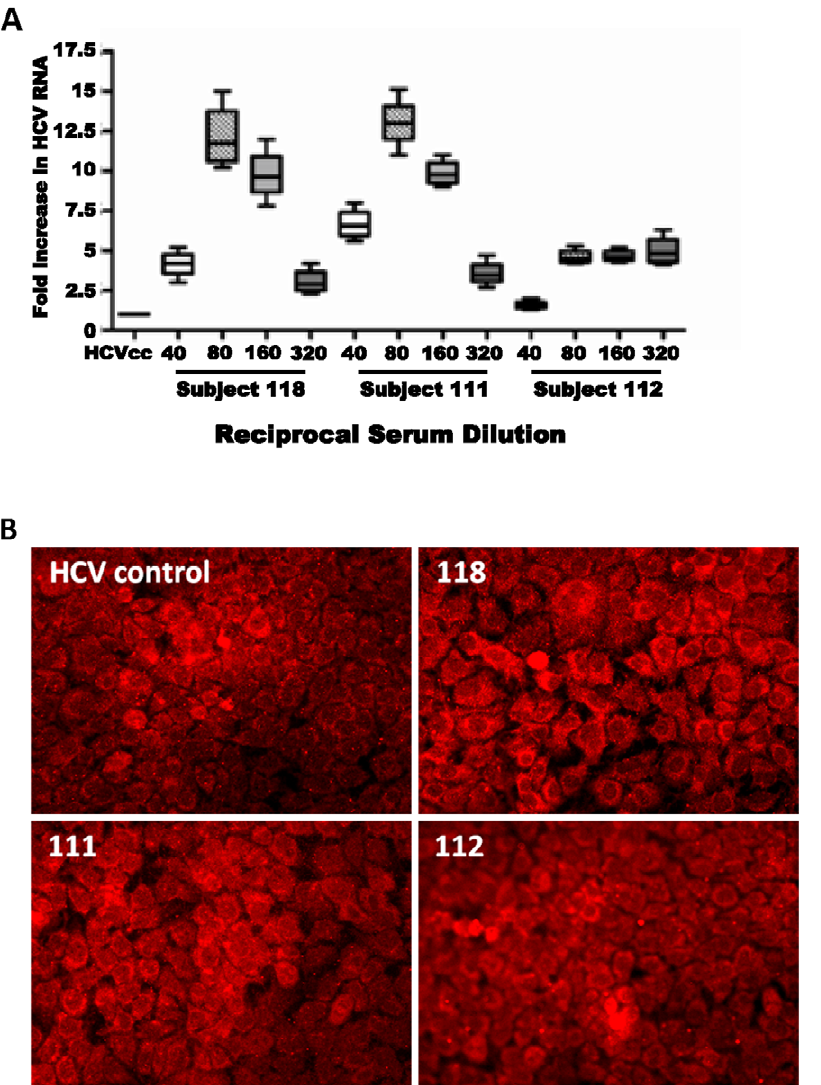
Figure 2. Enhancement of HCVgenotype 2a (clone JFH1) infectivity by serial dilutions of the selected vaccinee sera. A predetermined HCV titer was incubated with vaccinee sera for 1 h prior to addition to an Huh-7.5 cell monolayer for infectivity. Fold increase of HCV RNA by real-time PCR is shown (panels A). Sera were also analyzed for ADE by immunofluorescence, and photomicrographs were captured at 200X magnification (panel B). A predetermined number of FFU were used to infect Huh-7.5 cells in the presence or absence of vaccinee sera at a 1:80 dilution, followed by 72 h incubation. HCV protein expression was detected using an antibody specific to the HCV core protein, followed by anti-mouse immunoglobulin (Ig) conjugated with Alexa 568 (Molecular Probes, Eugene, OR). Cells infected with virus prior treated with vaccinee sera displayed a greater degree of infection as compared to infected controls in the absence of sera.